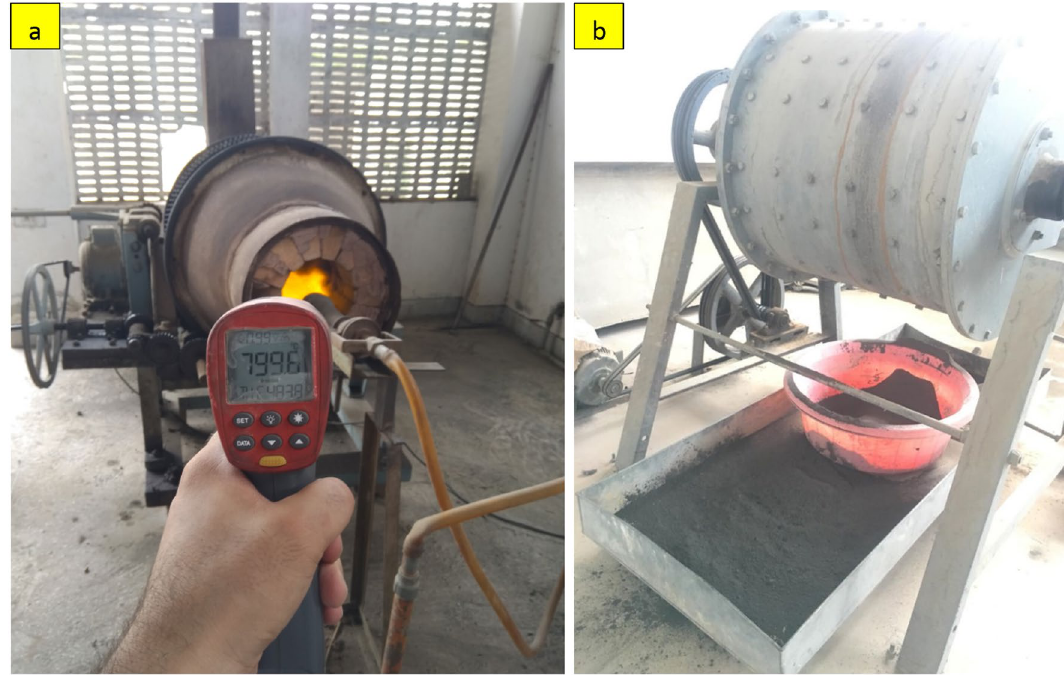
Figure 2. ( a ) Rotary kiln used in burning BA at different temperatures (600 °C and 800 °C), and ( b ) Rotary ball mill used in grinding of BA.